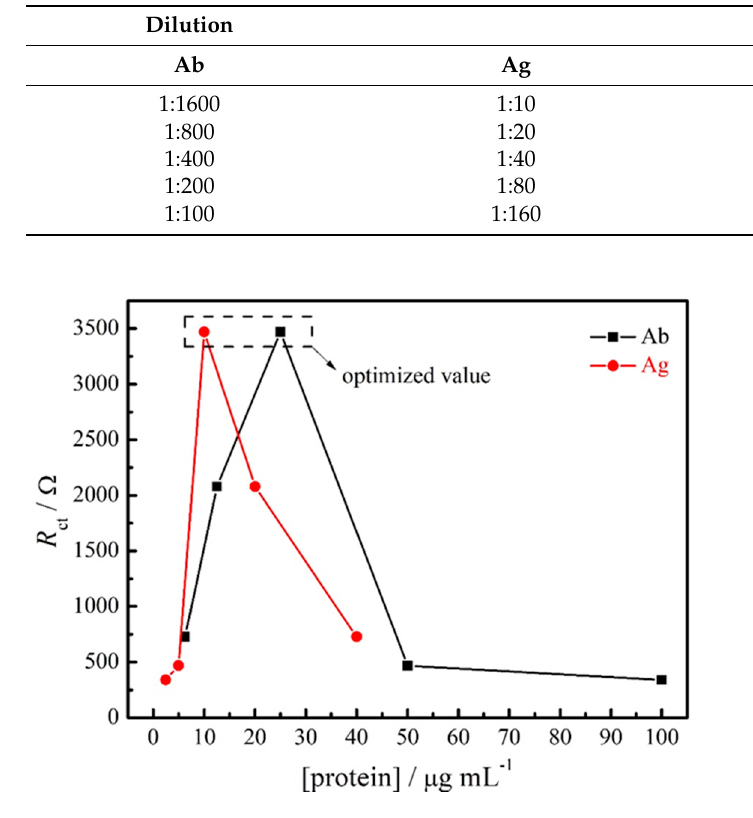
Figure 3. Optimization of antibody and antigen proteins concentrations at the immunosensor surface by EIS experiments.